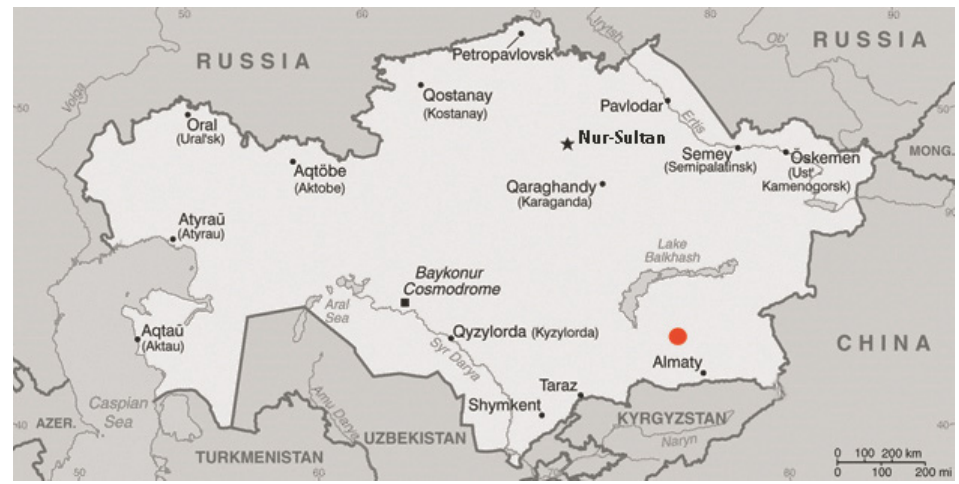
Figure 1. Location of sample collection from Kazakhstan.